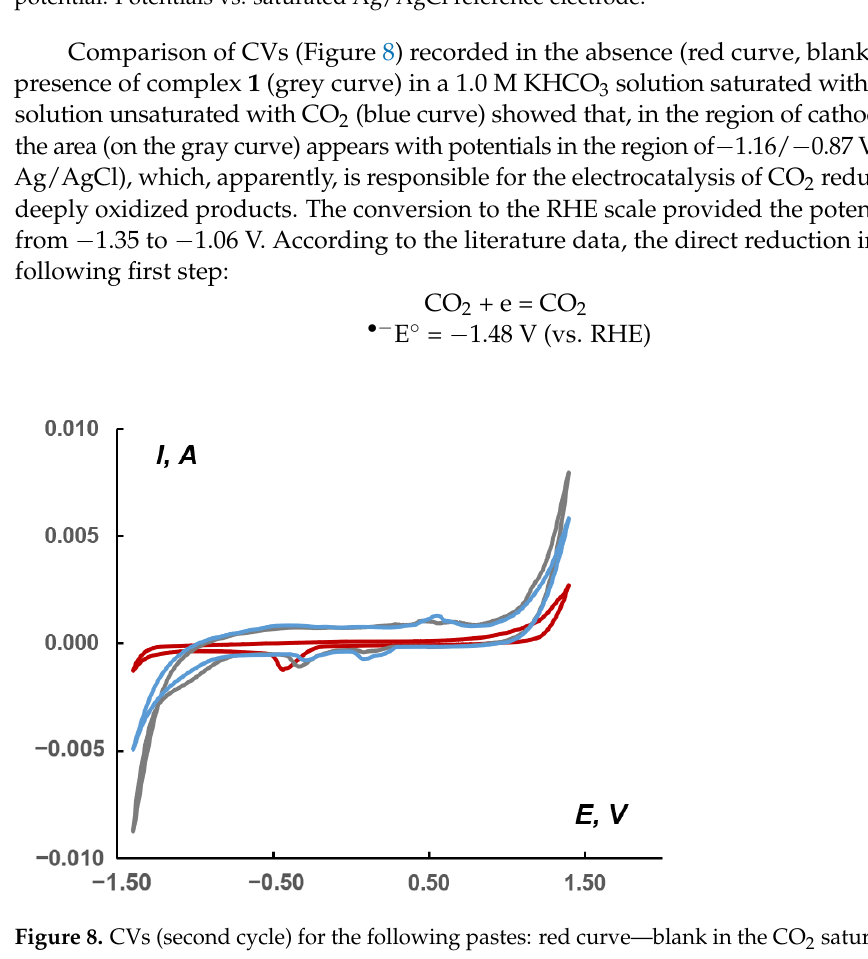
Figure 7. CVs (four consecutive cycles) for the paste electrode including carbon powder, 1 , and Nafion 10% aqueous dispersion in the ratio of 100:10:4 (the last component calculated as the dry mixture). The measurements were made at 10 mV/s scan rate in CO 2 -saturated 1.0 M KHCO 3 . Black arrows indicate the sequence of cycles, and red ones — the starting point and direction of CV starting potential. Potentials vs. saturated Ag/AgCl reference electrode.